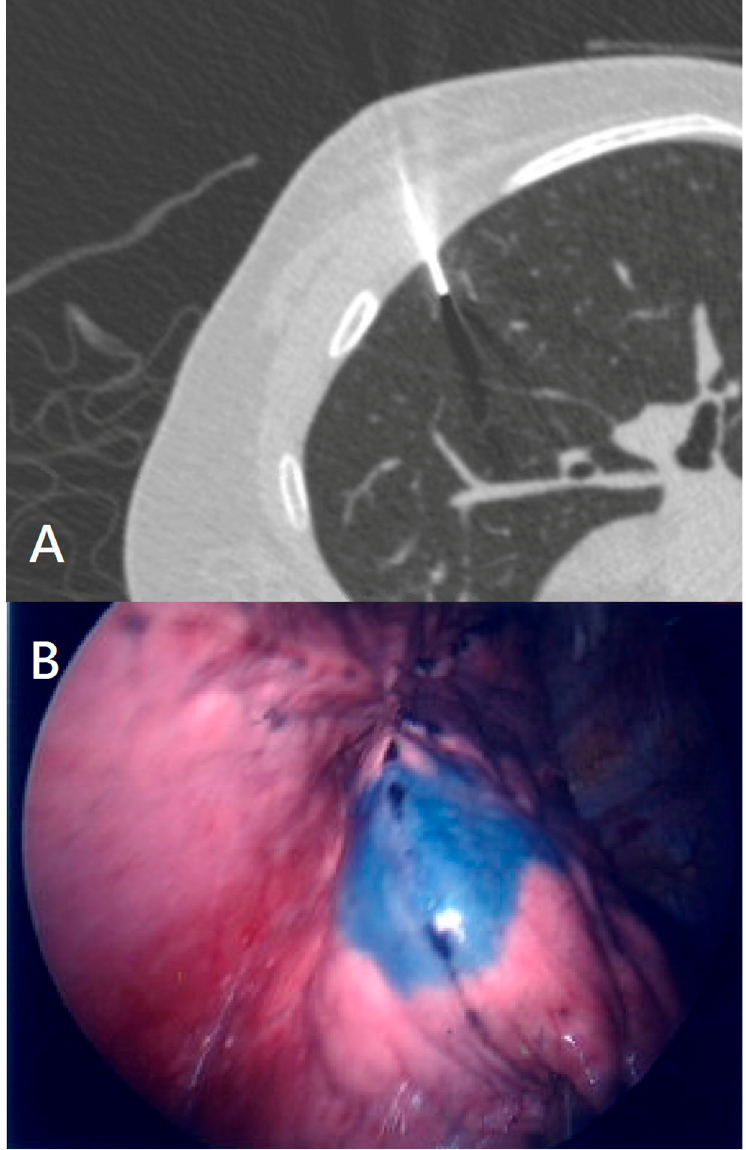
Figure 2. ( A ) CT-guided localization of fine-needle localization with PBV (Patent Blue Vital); ( B ) Pleural marking by CT-guided localization method revealed by VATS.